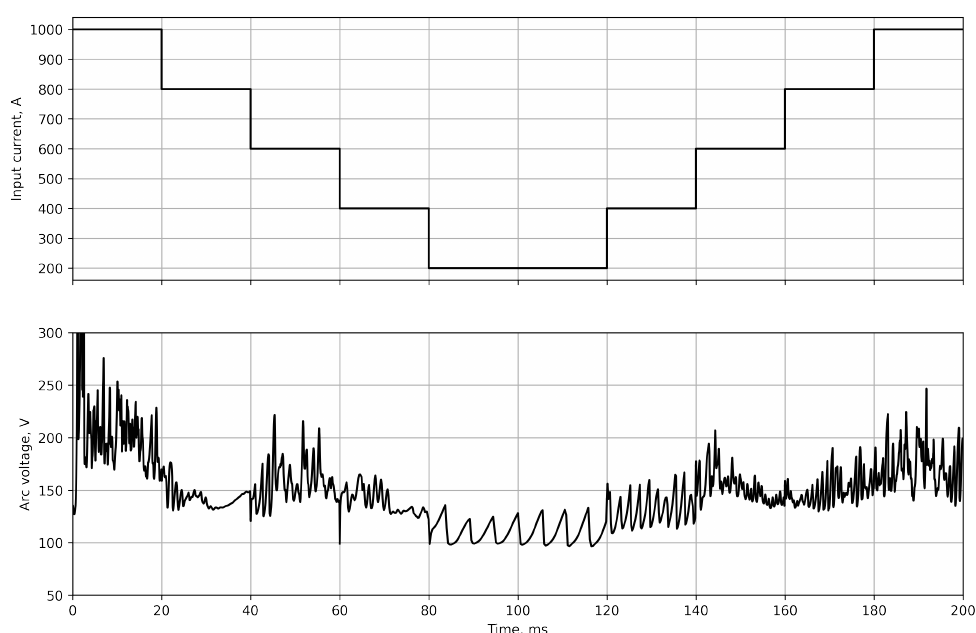
Figure 8. Arc voltages over the entire current sweep. x CO = 0.7, L a = 0.05